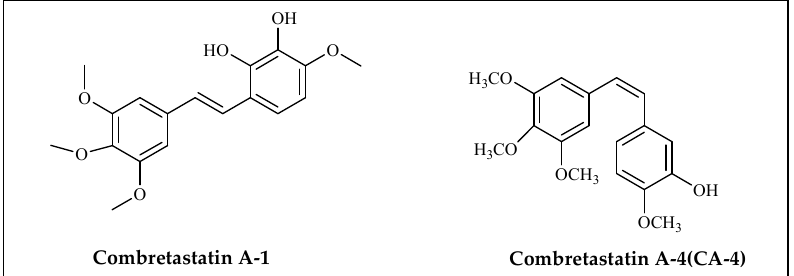
Figure 5. Combretastatins with anticancer activity.